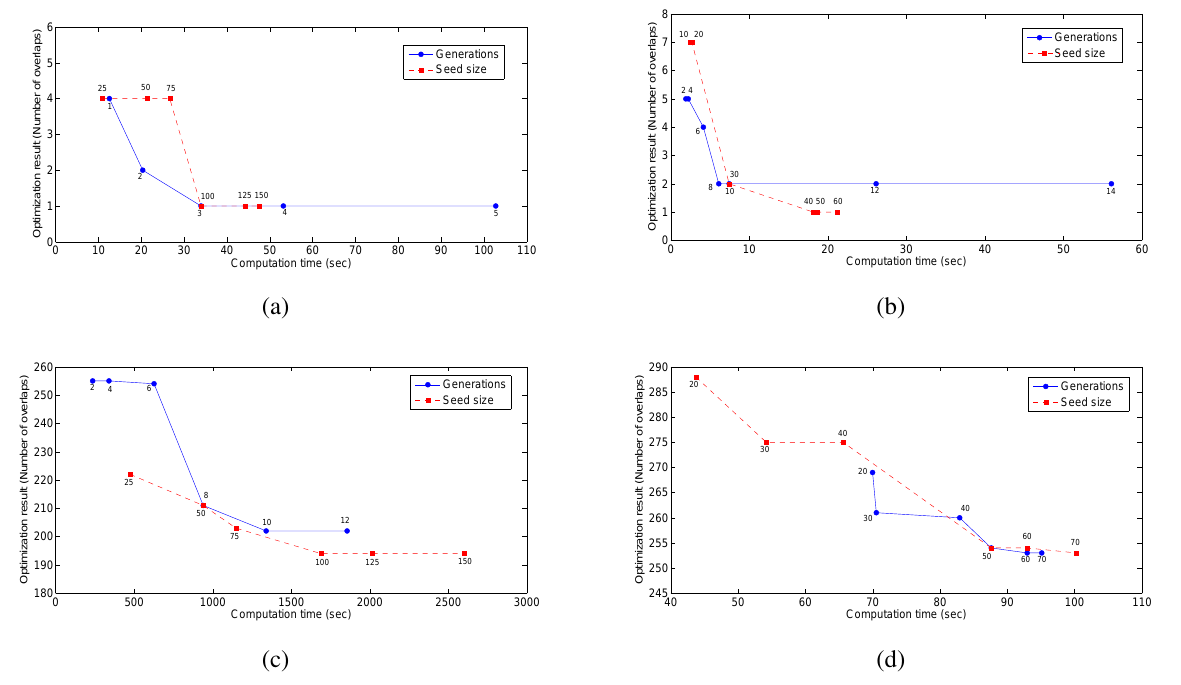
Figure 2. Evaluation of the parameters to select for application of GA and PSO. ( a ) Tuning for the GA in the Hanoi network; ( b ) tuning for the PSO in the Hanoi network; ( c ) tuning for the GA in the Limassol network; ( d ) tuning for the PSO in the Limassol network. For the Limassol network, the parameters were selected as follows: A seed matrix of 100 rows and five generations are allowed. The GA algorithm is run 10 times ( i.e. , a total of 10 iterations). For the PSO, a seed matrix of 50 rows was selected allowing 50 generations. The PSO algorithm will be run 150 times; this means that we are allowing 150